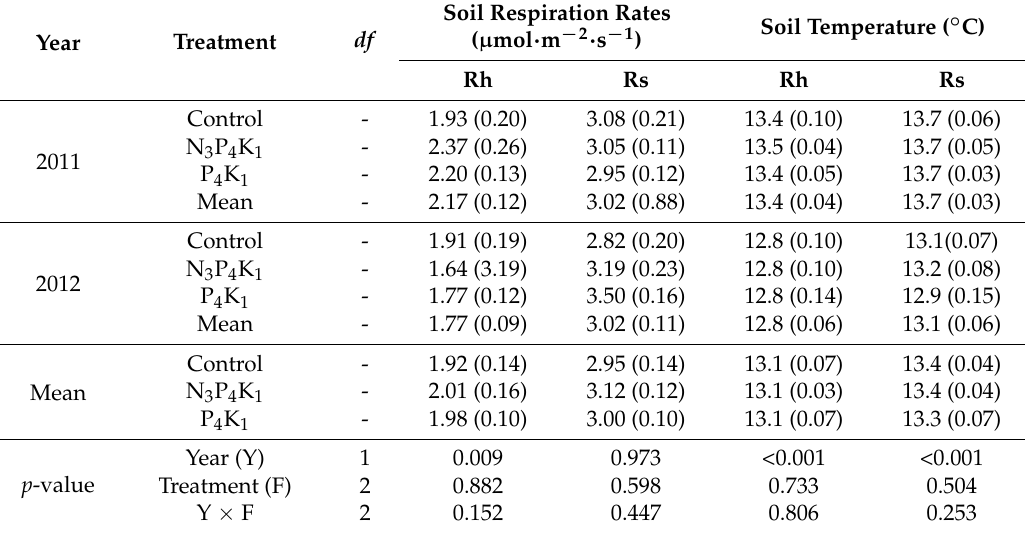
Values in parenthesis represent standard errors ( n = 12).